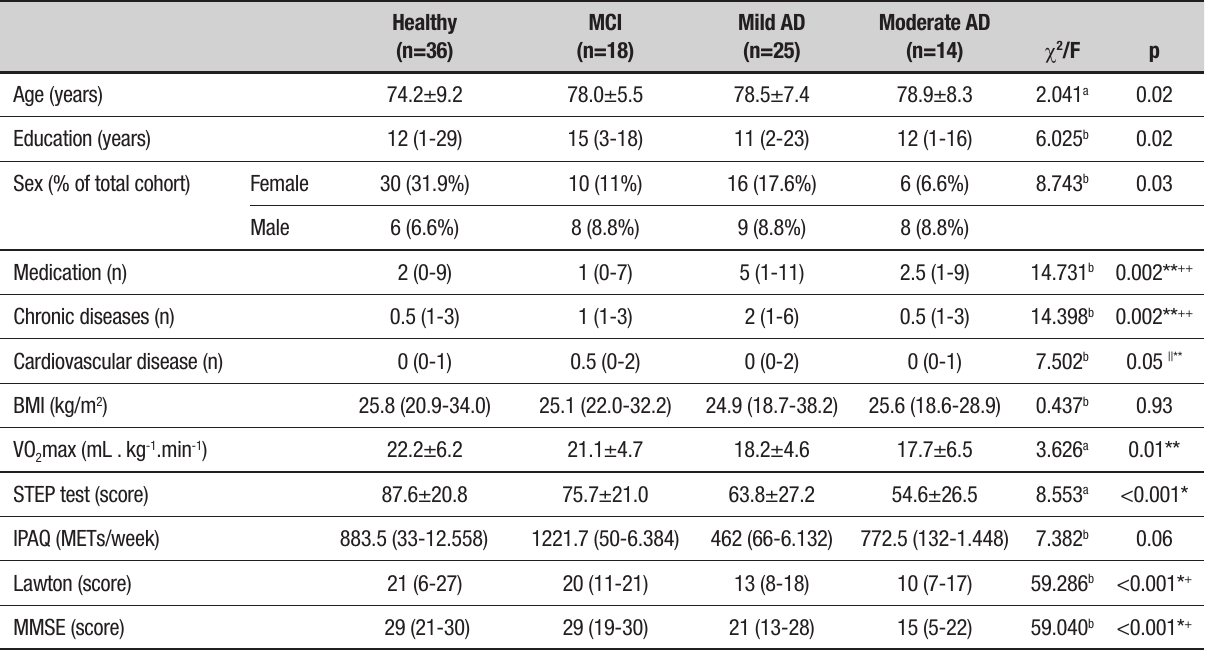
Table 1. Descriptive analyses of the samples.